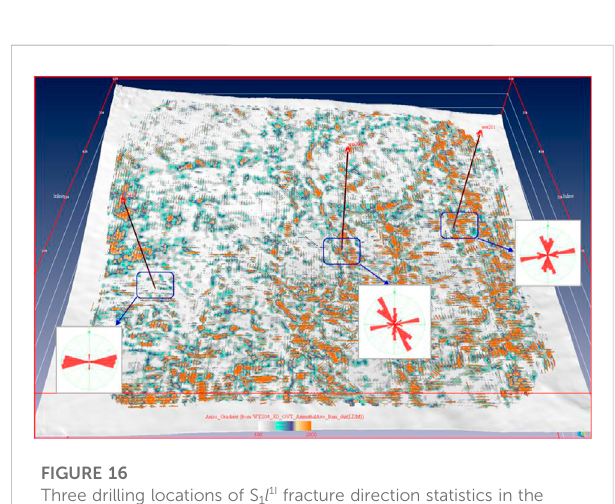
FIGURE 16 Three drilling locations of S 1 l 1I fracture direction statistics in the W204 well